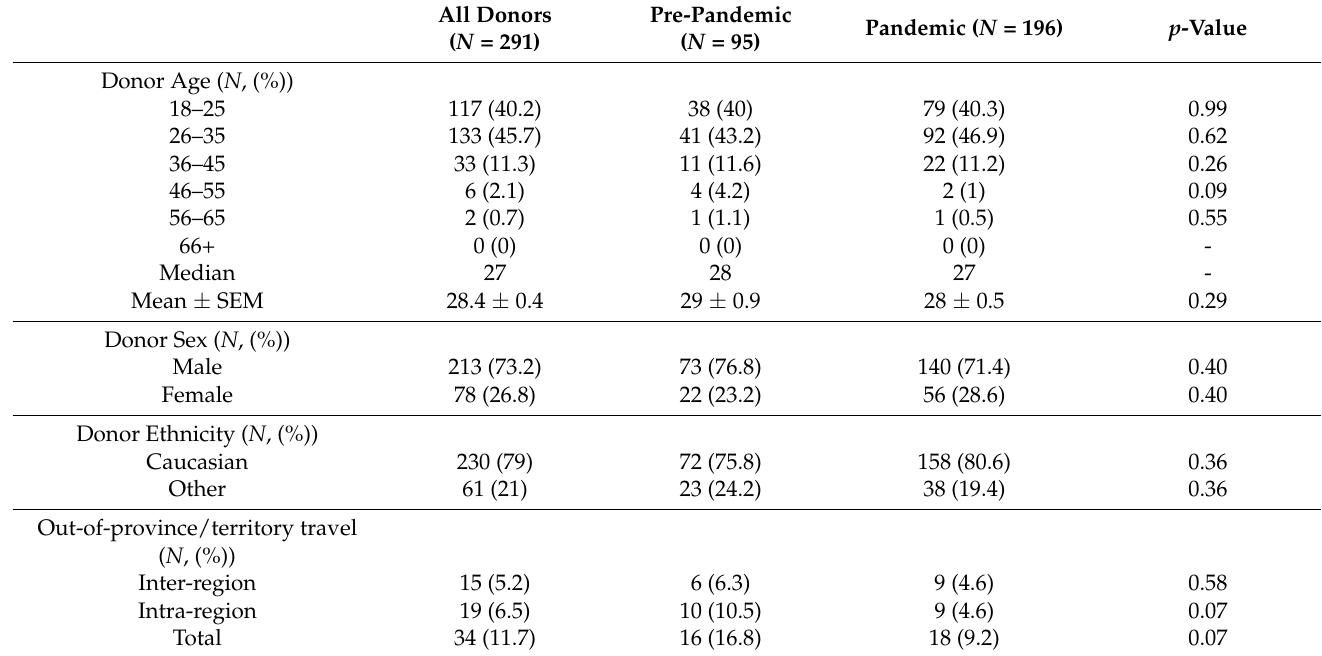
Table 1. Characteristics of Allogeneic PBSC Transplant Unrelated Donors.